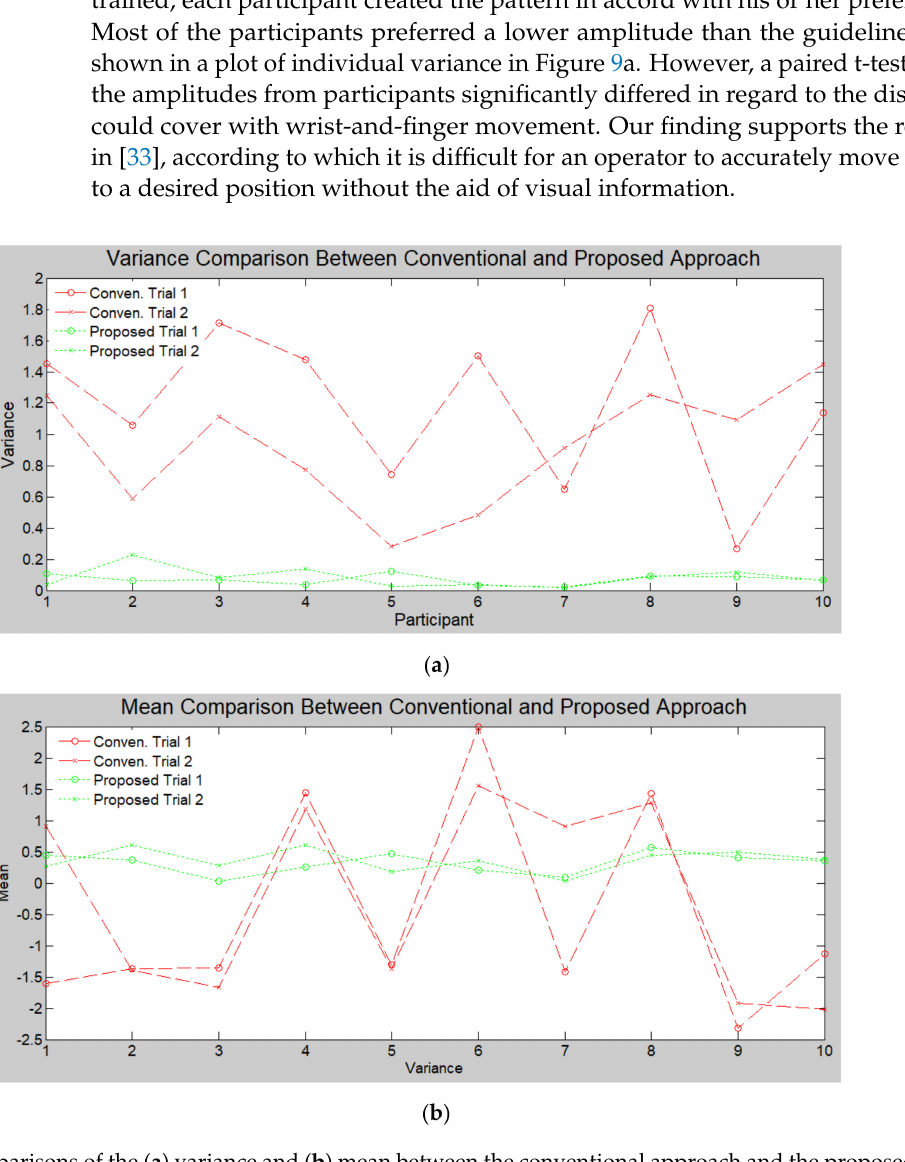
Figure 9. Plot comparisons of the ( a ) variance and ( b ) mean between the conventional approach and the proposed